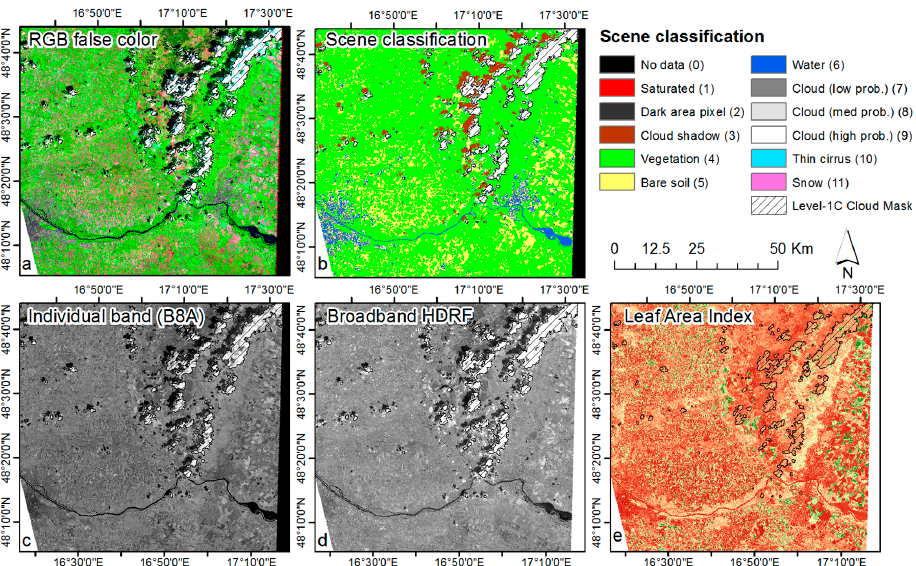
Figure 1. Examples of a Sentinel-2 100 × 100 km 2 images (tile 33UXP, covering the region between Vienna and Bratislava, acquired on 6 May 2016) and value-added products available at the data service platform. Note that clouds extracted from the Level-1C cloud mask are displayed (as hashed